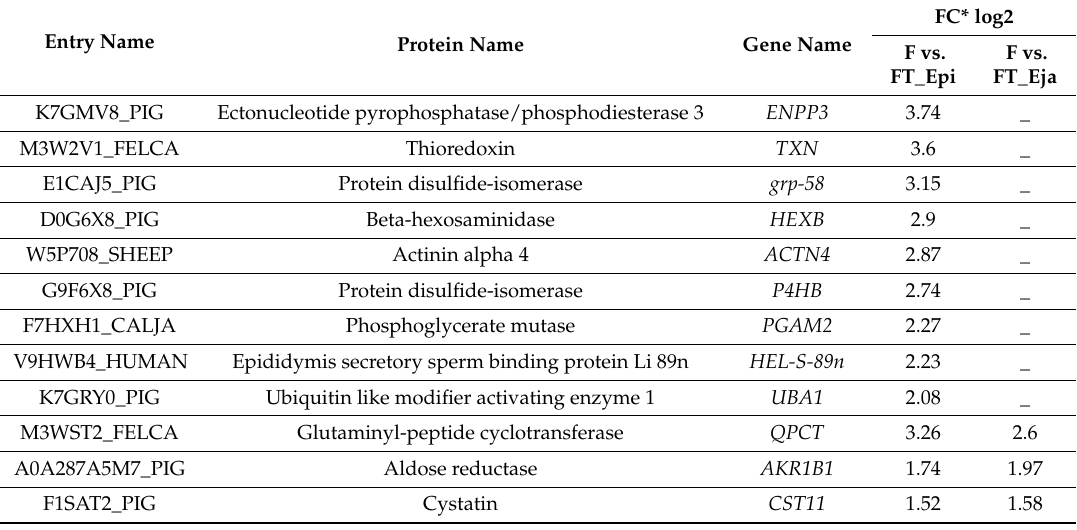
Table 3. Proteins differentially abundant between fresh (F) and frozen-thawed (FT) pig spermatozoa from cauda epididymis (Epi) and ejaculate